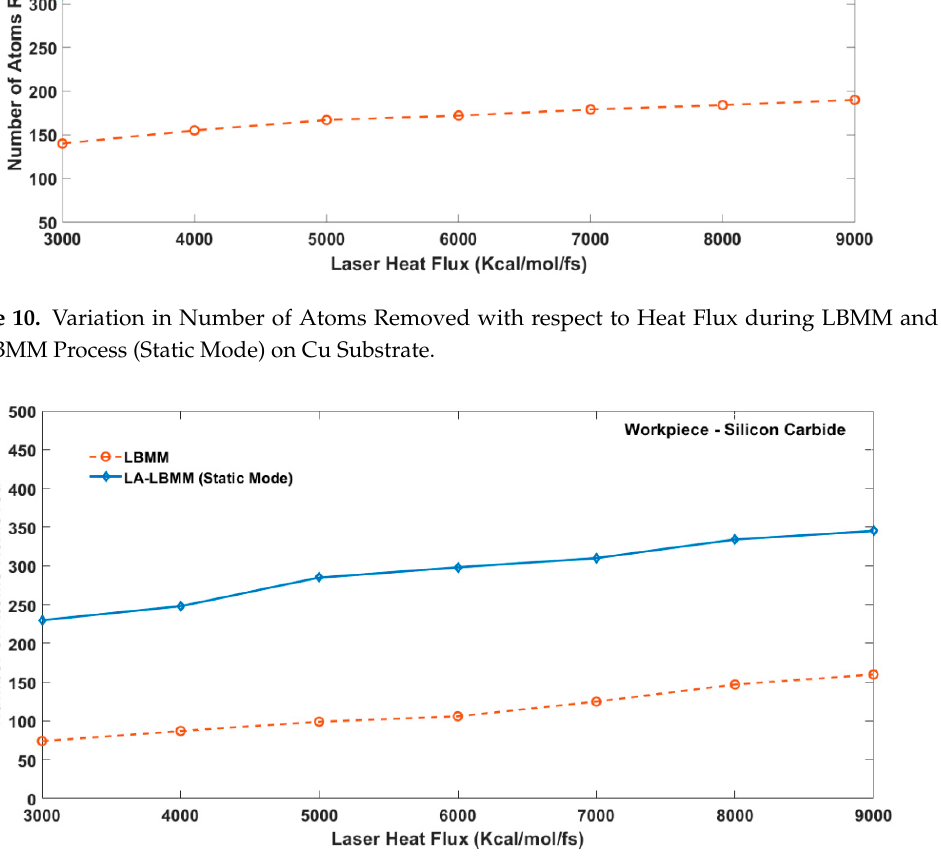
Figure 12. MD Simulation Snapshot of Cavity Machined during the LA-LBMM Process (Dynamic Mode). The comparison between variations in the number of atoms removed during LA-LBMM for both static and dynamic modes are shown in Figure 13. It is seen that the number of atoms removed from the substrate is relatively less in the dynamic mode compared to static mode. It can be explained because the flowing water carries the heat away from the machining zone, resulting in lesser material removal. Moreover, the cavities have reduced re-deposition during the dynamic mode.